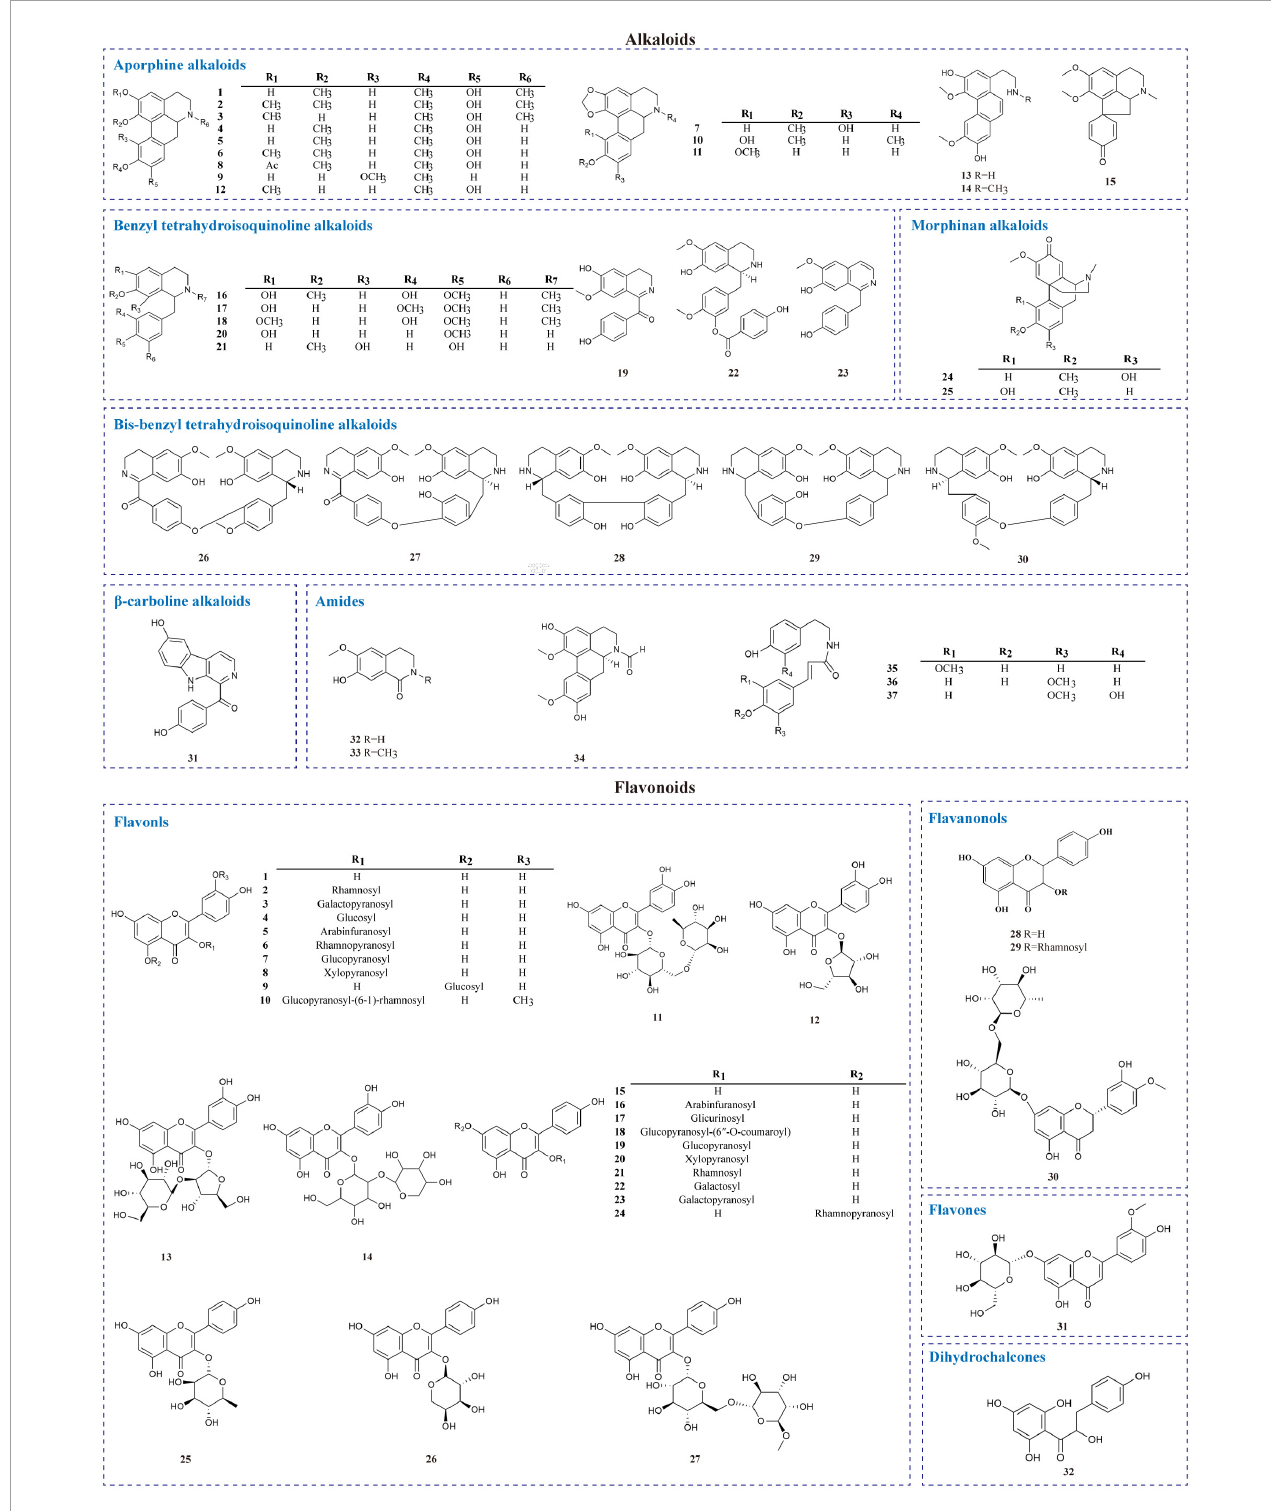
FIGURE3 Chemical structures of alkaloids and flavonoids in L. aggregata.